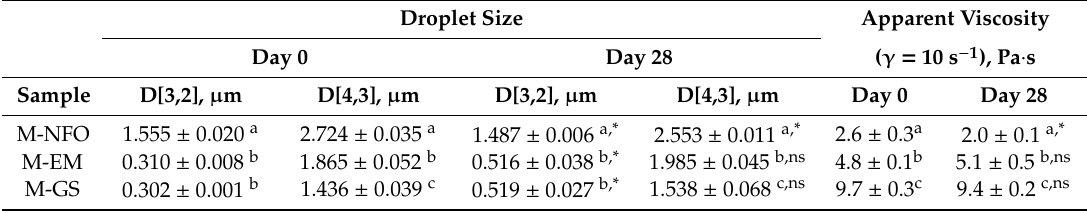
Table 2. Droplet size and apparent viscosity ( γ = 10 s − 1 ) of fortified low-fat mayonnaise enriched with neat fish oil (M-NFO), emulsified fish oil (M-EM) or microencapsulated fish oil